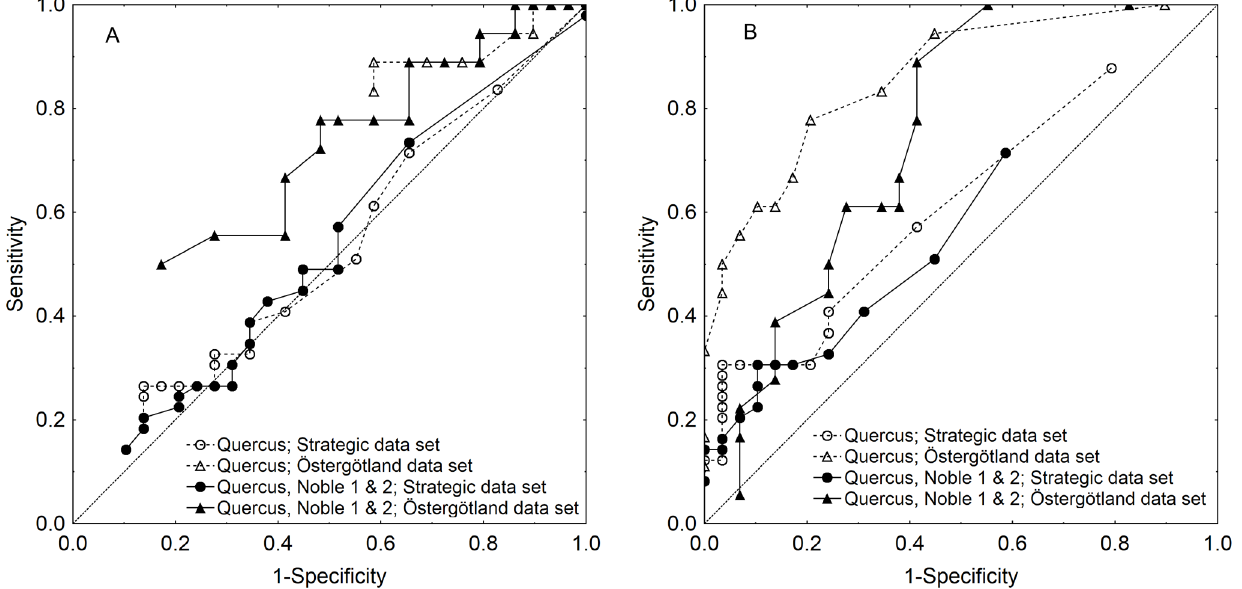
Figure 7. Sensitivity and specificity of two models in predicting the occurrence of Elaterferrugineus at trapping sites. The ‘strategically sampled data set’ consisted of data from the same study area (40 km 6 40 km) as used in the main analyses, while the ‘O¨ stergo¨tland data set’ hotspot sampling over a larger geographic area. Models were either based on density of Quercus only, or by the combined density of Quercus and the tree groups Noble 1 and Noble